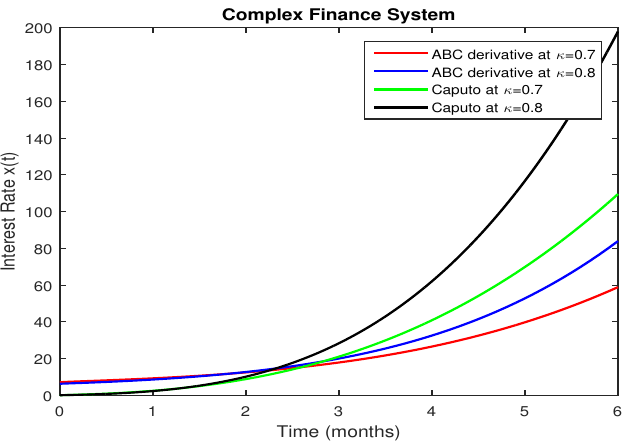
Figure 7. x ( t ) interest rate with Caputo and ABC derivative.